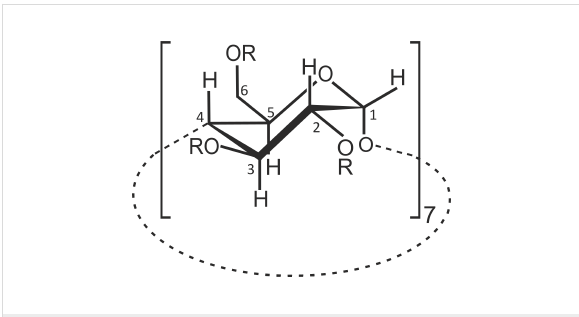
Figure 9: Carbon (and corresponding proton) numbering of cyclo- dextrins, herein demonstrated for β